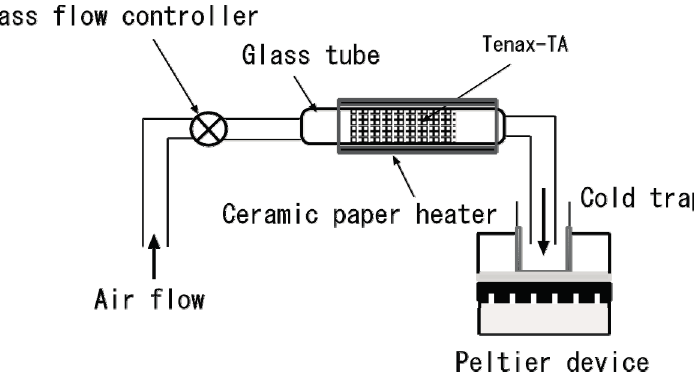
Figure 13. Schematic diagram of preconcentrator